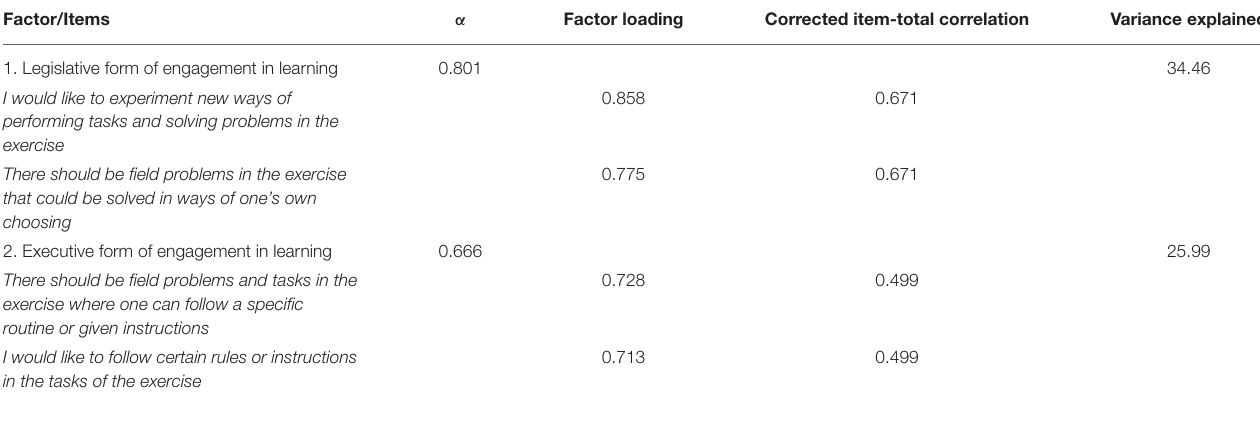
TABLE A1 | Two-factor solution and results of item analysis for preferred forms of engagement in